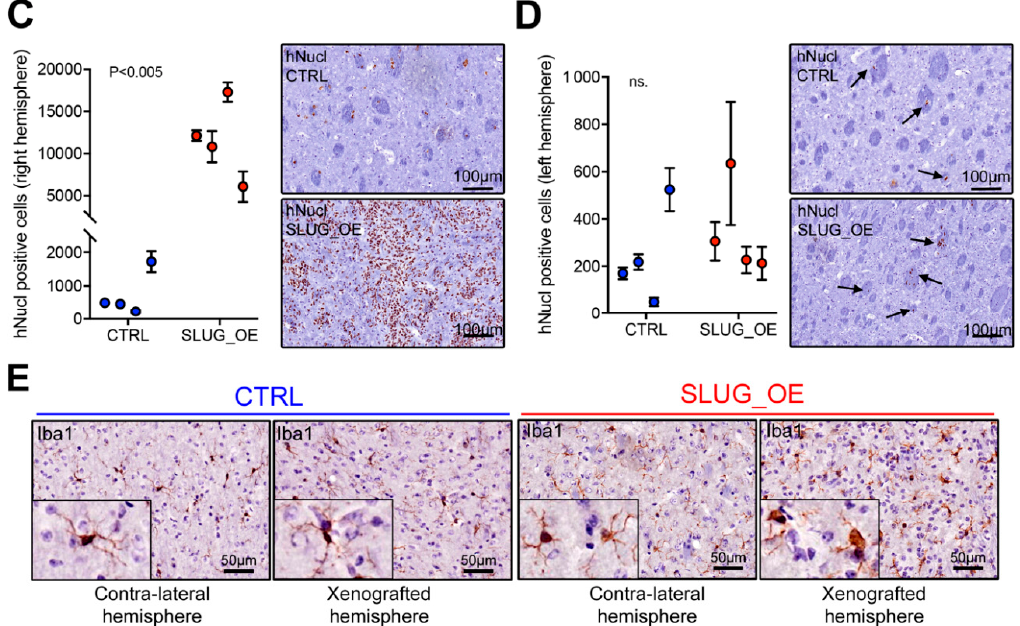
Figure 6. SLUG overexpression in a quiescent stem-like BTSC line promotes tumor initiation in vivo (see also Figure S8). ( A ) Brain MRI of mice a year post-xenograft with BT50 CTRL or SLUG_OE cells (dashed lines represent approximate delimitation of enhancing regions) and ( B ) representative hNucl staining (dashed line represents an approximate tumor delineation). Quantitative analysis and representative close-up hNucl staining of ( C ) the implanted (right) hemisphere and ( D ) the contralateral (left) hemisphere (error bars represent SD). ( E ) Representative images and 2.5× close-up inserts of Iba1 staining in the xenografted and contra-lateral hemispheres of CTRL and SLUG_OE xenografted mice.